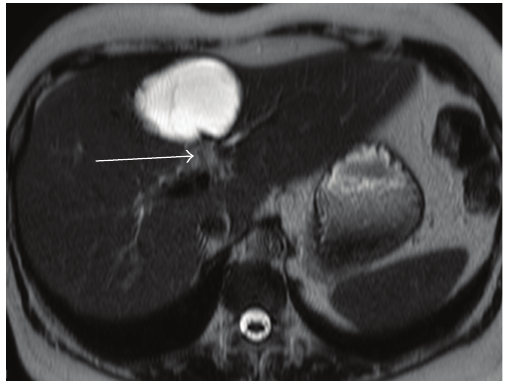
Figure 3: Thick slice cholangioMR. Mural nodule protruding in the left hepatic bile duct with upstream enlargement of this duct.